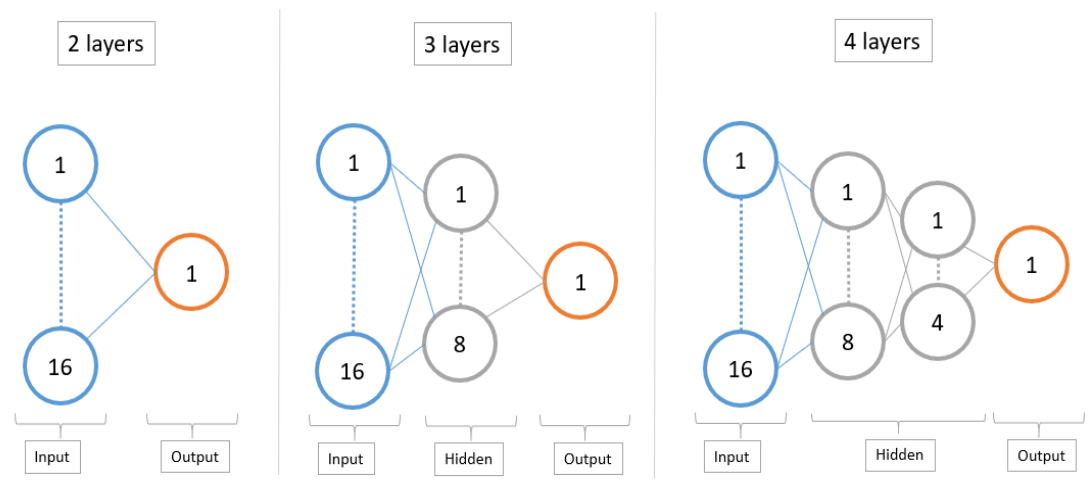
Figure 8. Source: Tests carried out on the variation of layers. Own elaboration.